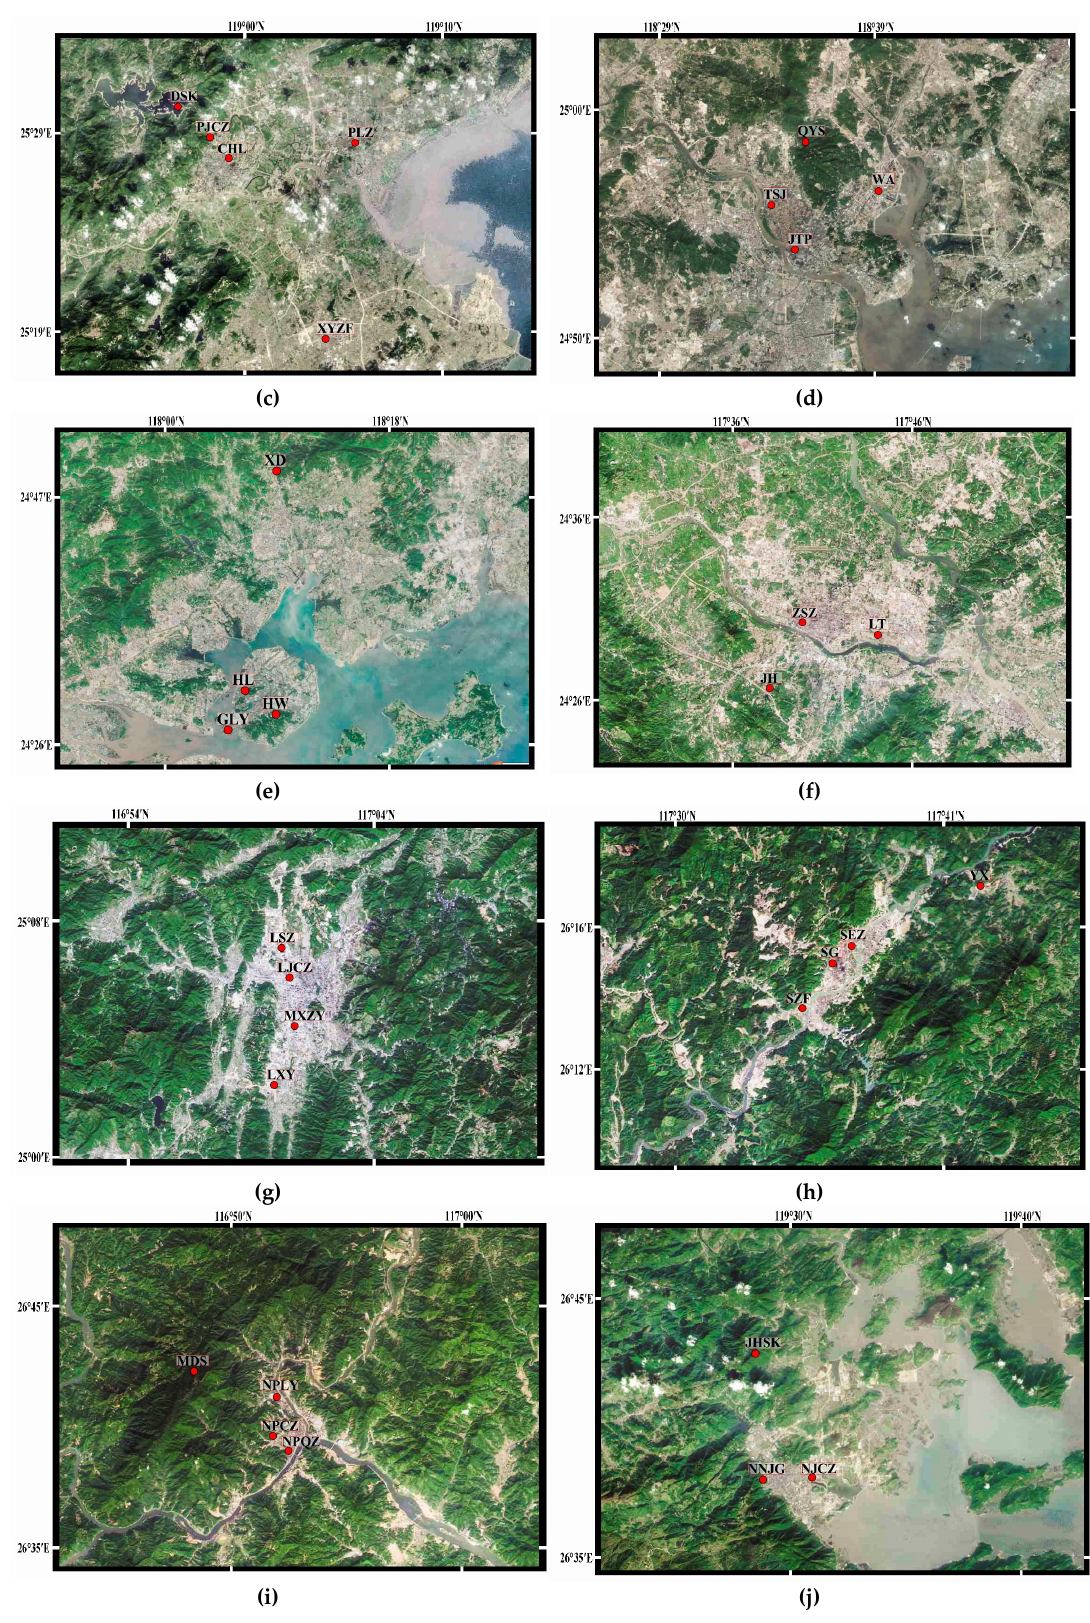
Figure 1. The locations of the 9 major cities in Fujian province ( a ) and the locations of the monitoring sites ( b ) in Fuzhou city; ( c ) in Putian city; ( d ) in Quanzhou city; ( e ) in Xiamen city: ( f ) in Zhangzhou city; ( g ) in Longyan city; ( h ) in Sanming city; ( i ) in Nanping city; and ( j ) in Ningde city.